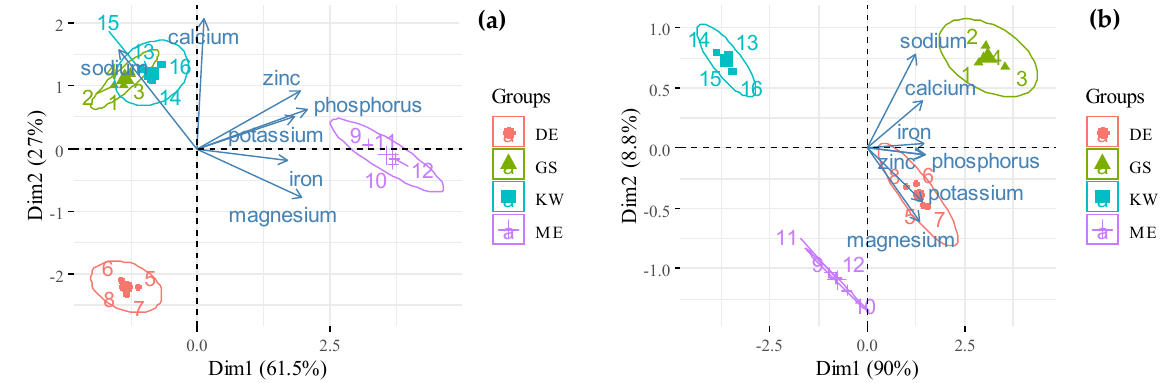
Figure 7. Element concentration ( a ) and element yield ( b ). Only the location along the Dim1 axis requires analysis. The Dim2 axis only helps separation but does not provide any additional information about the correlations. The highest element yield was observed in the following order of hybrids: GS, DE, ME and KW. This order is the same as that of yield.